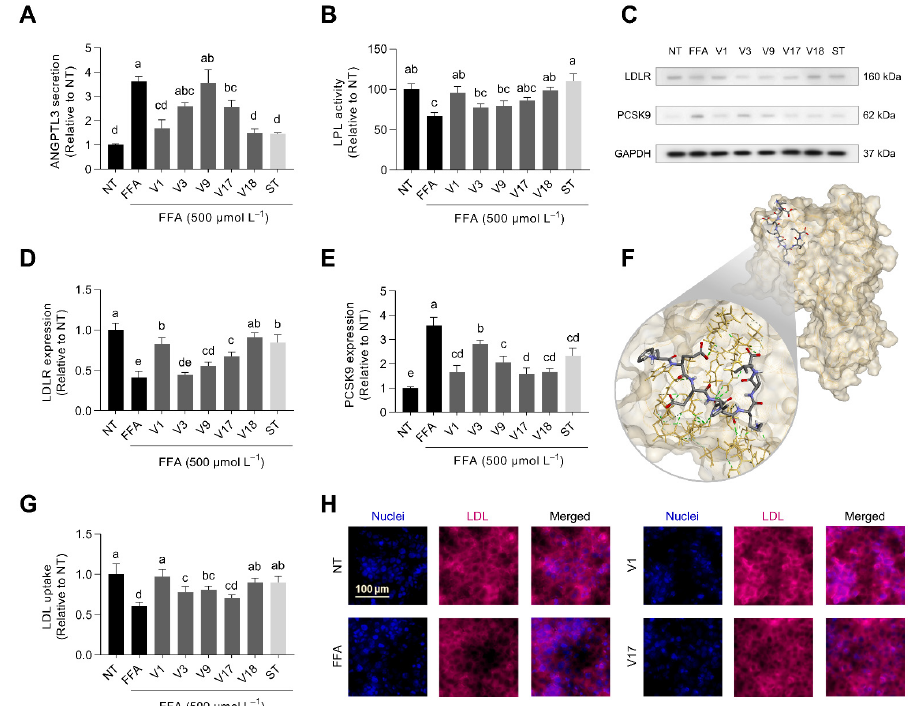
Figure 8. Effect of selected soybean digests (V1, V3, V9, V17, and V18 at 253, 160, 76, 64, and 146 µ g protein mL − 1 , respectively) and simvastatin (ST, 160 ng mL − 1 ) on the secretion of angiopoietin-like 3 (ANGPTL3) ( A ), the activity of lipoprotein lipase (LPL) ( B ), the relative protein expression ( C ) of the LDL receptor (LDLR) ( D ) and proprotein convertase subtilisin/kexin type 9 (PCSK9) ( E ) in free fatty ‐ acid ‐ stimulated HepG2 liver cells (500 μ mol L − 1 oleic: palmitic acid, 2:1). Representation of the PCSK9 ‐ peptide (FEEINKVL) in silico interaction in the LDLR binding site ( F ). LDL uptake in hepatocytes co ‐ treated with FFA and selected soybean varieties digested under gastrointestinal con ‐ ditions ( G , H ). Results are reported as mean ± SD ( n = 3). Bars with different letters significantly differ according to ANOVA and Tukey’s multiple range test ( p < 0.05).